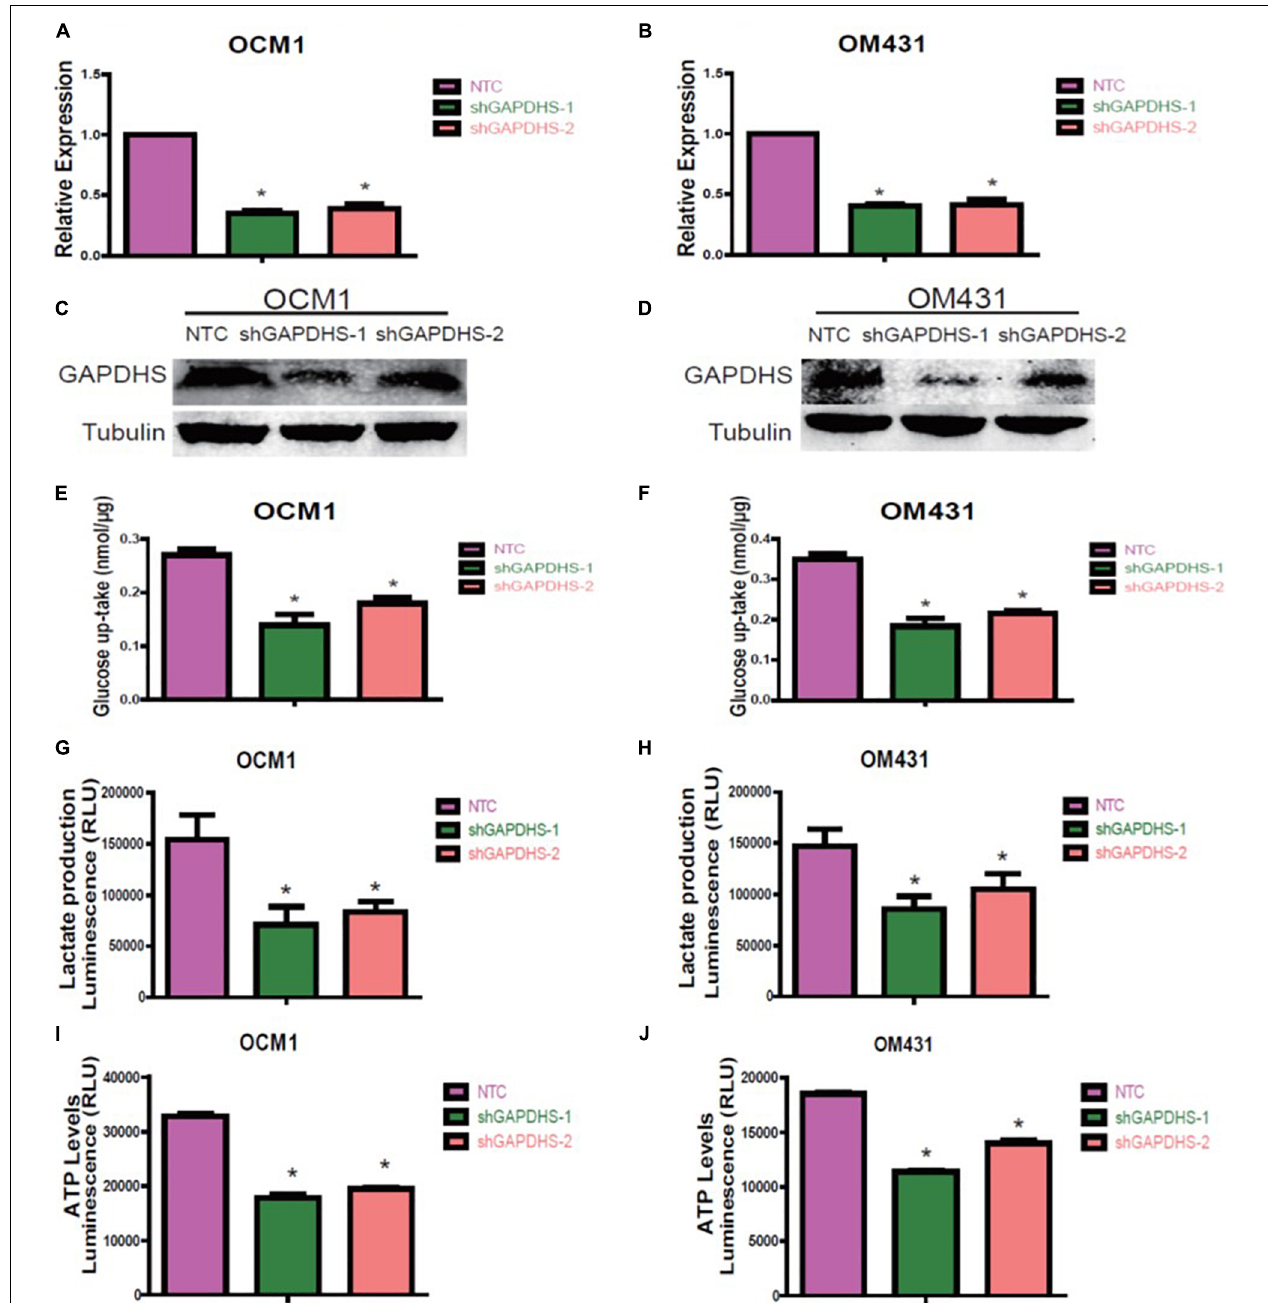
FIGURE 2 | Glyceraldehyde-3-phosphate dehydrogenase (GAPDHS) knockdown inhibits glycolysis in melanoma cell lines. (A,B) Real-time PCR demonstrated that two shRNAs (shGAPDHS-1 and shGAPDHS-2) could silence GAPDHS expression in OCM1 and OM431 cells. Non-targeting control (NTC) indicates cells expressing NTC. * P < 0.05 compared with the NTC group. (C,D) Western blot verified that shGAPDHS-1 and shGAPDHS-2 efficiently silenced GAPDHS at the protein expression level in OCM1 and OM431 cells. Tubulin served as the loading control. (E–J) Glucose uptake (E,F) , lactate production (G,H) , and ATP levels (I,J) were measured in OCM1 and OM431 cells stably expressing NTC and two shRNAs of GAPDHS. Data are presented as the mean ± SE. * P < 0.05 compared with the NTC group.